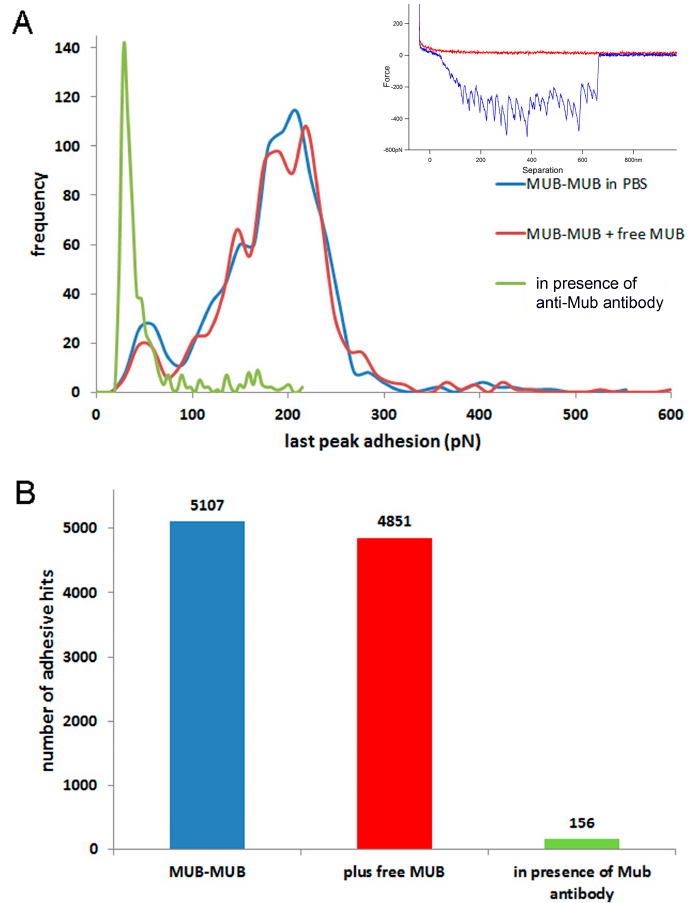
Figure 6. AFM force spectroscopy of MUB–MUB in absence or presence of free MUB or anti-Mub antibody. ( A ) Histograms of the “rupture” adhesion forces. Inset: example force curve and ( B )